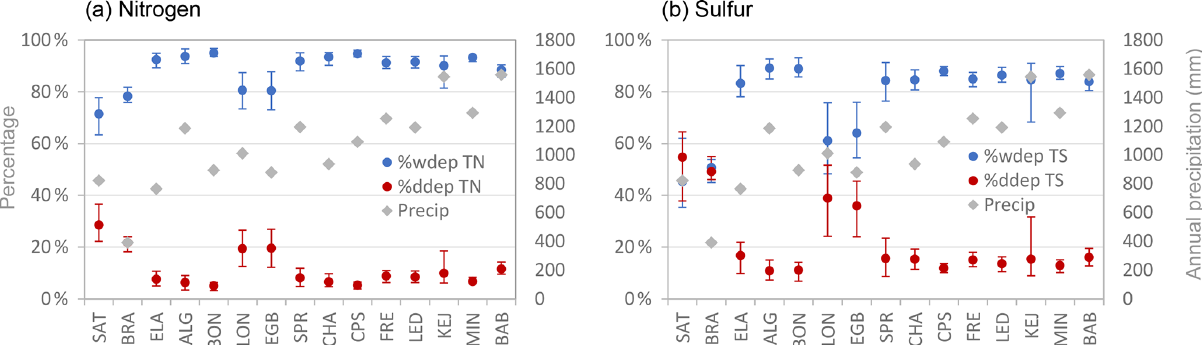
Figure 7. Percentage of wet and dry annual deposition of (a) nitrogen and (b) sulfur at CAPMoN sites during 2000–2018. %ddep TN includes dry deposition of oxidized N (HNO 3 and pNO − in the percentage (error bars); mean annual precipitation amount (diamonds). Sites are listed in order longitudinally from west (left) to east